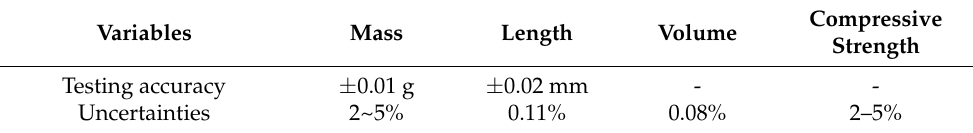
Table 2. Testing accuracy and